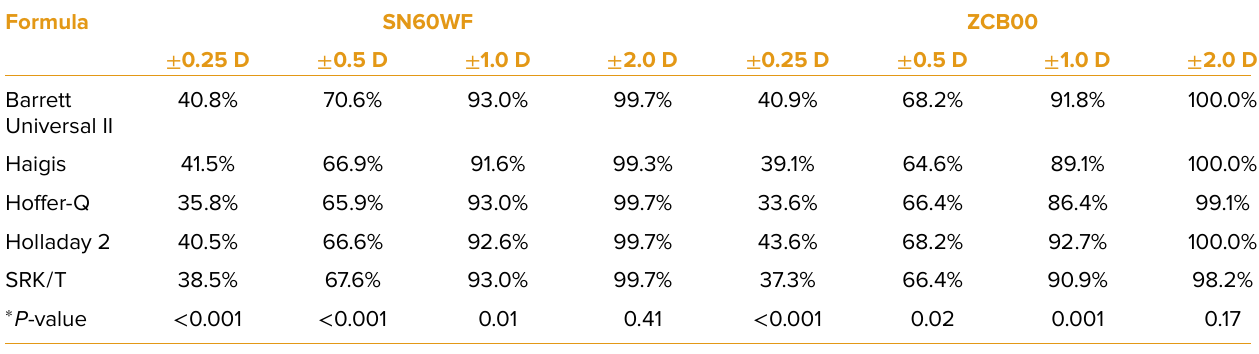
Table 3. Percentage of eyes within ± 0.25 D, ± 0.5 D, ± 1.0 D, and ± 2.0 D of the predicted refraction for both SN60WF and ZCB00 lenses.